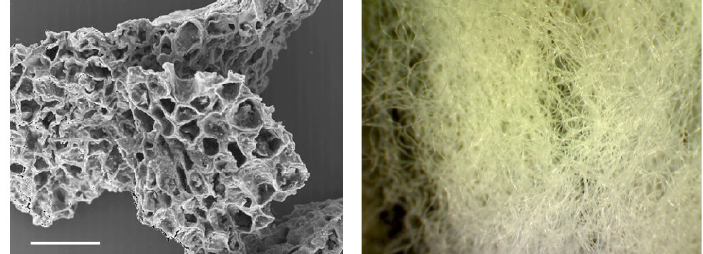
Figure 4. SEM image of waste coffee grounds (bar = 100 µm) [26] (left) and filter of cigarette recorded on PCE -MM200 microscope at 12.5x magnification (right)